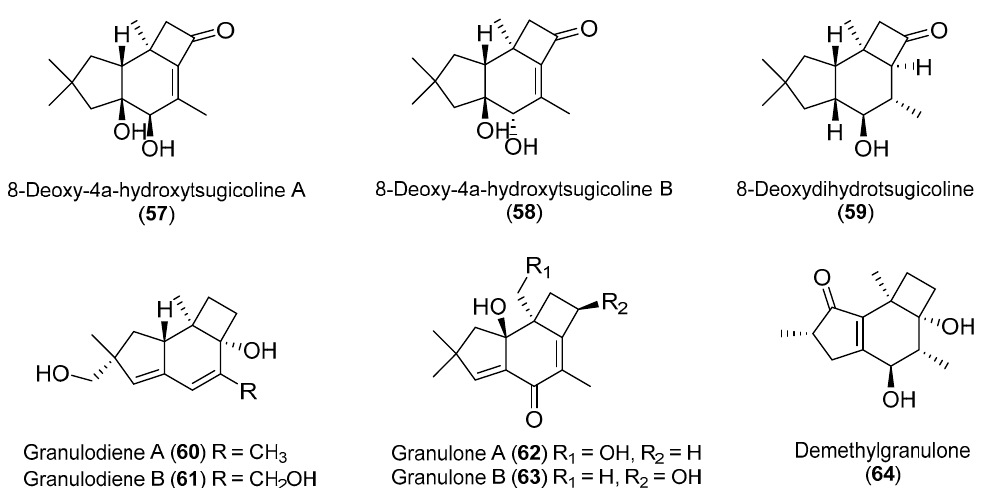
Figure 12. Structures of protoilludanes 57 – 64 isolated from Granulobasidium vellereum.